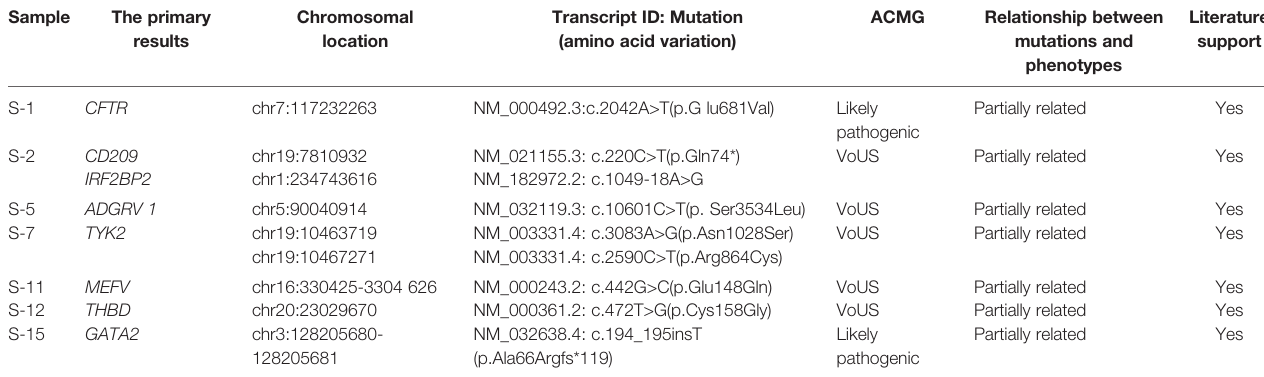
TABLE 2 | The positive results of whole exon sequencing.